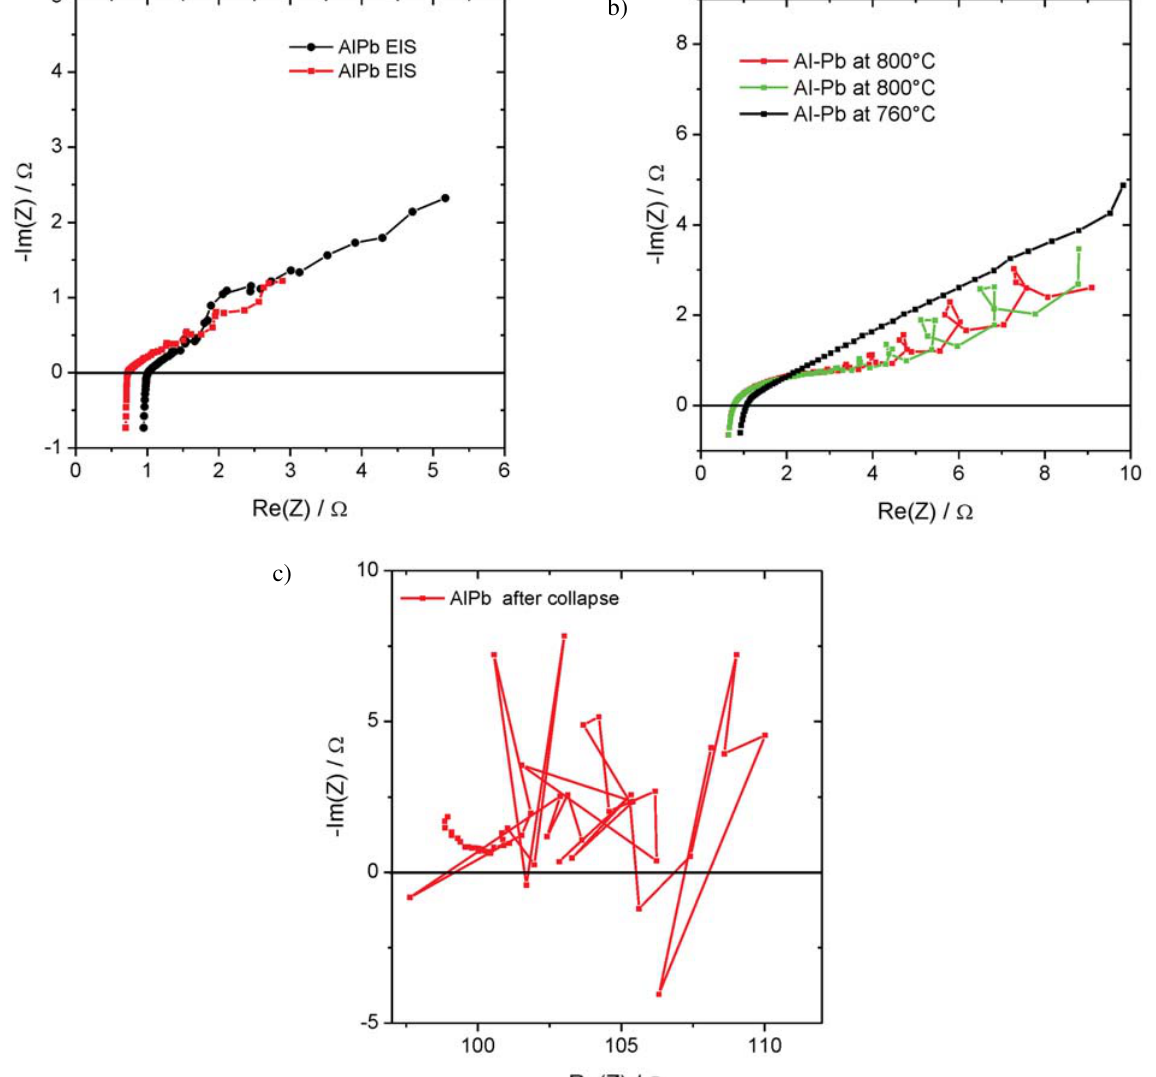
Figure 5. Complex plane impedance spectra for (a) two measurements of Al-Pb cell, (b) for Al-Pb in electrolyte B at three different temperatures, (c) for a “collapsed” Al-Pb